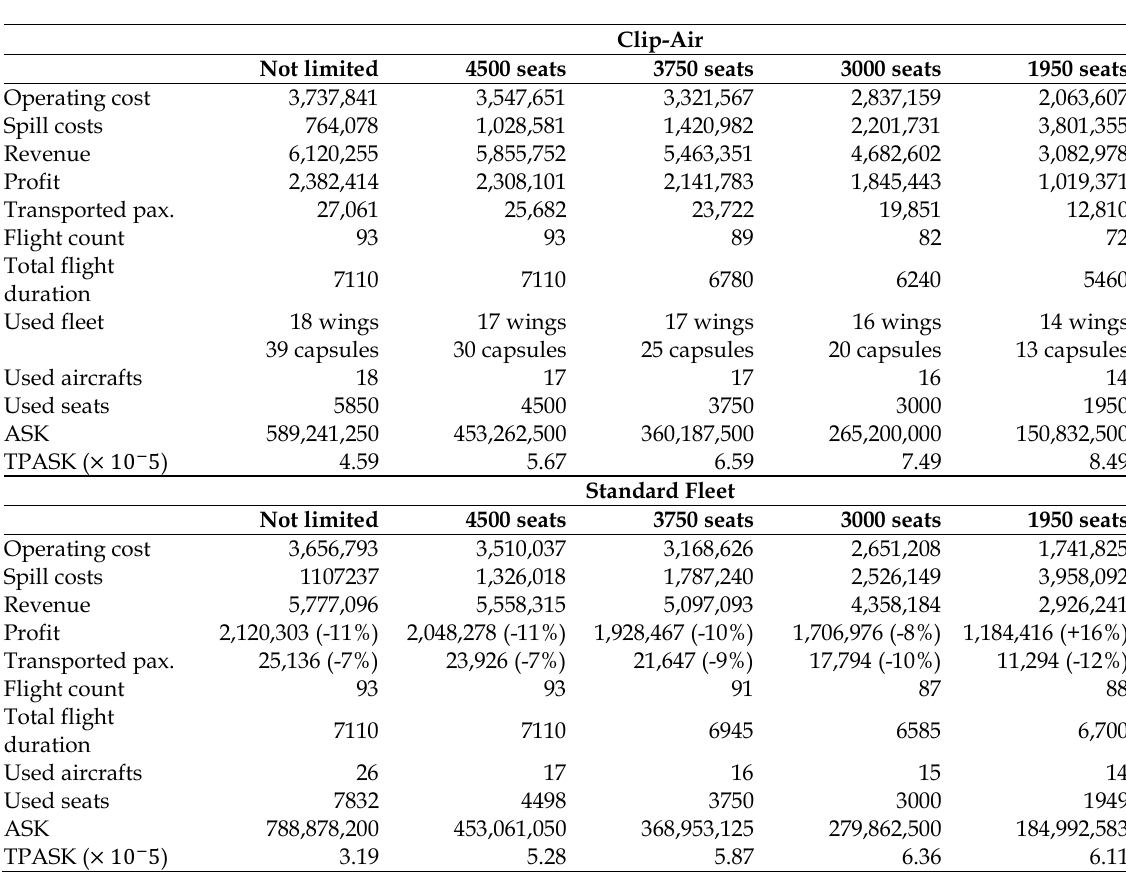
Table 12. Results with varying available